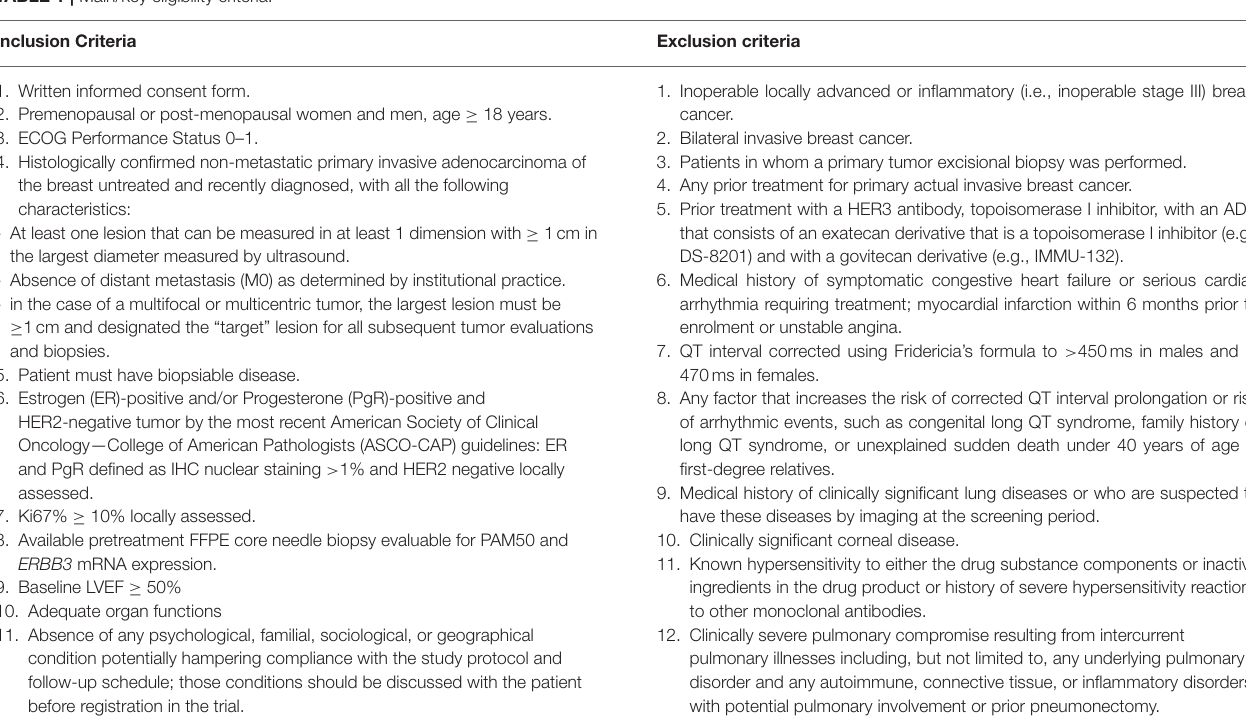
TABLE 1 | Main/key eligibility